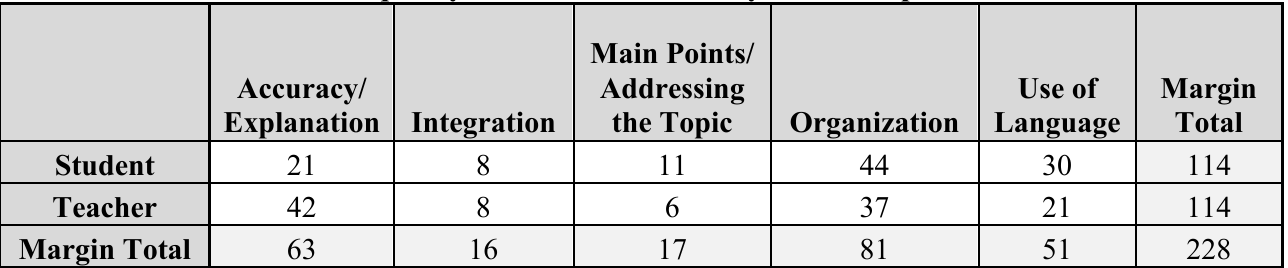
Frequency of Source Feedback by Rubric